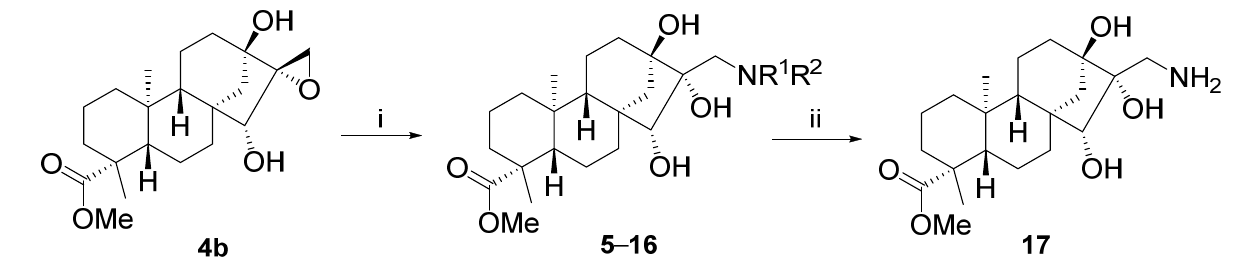
Table 1. Stereoselective syntheses of steviol-derived